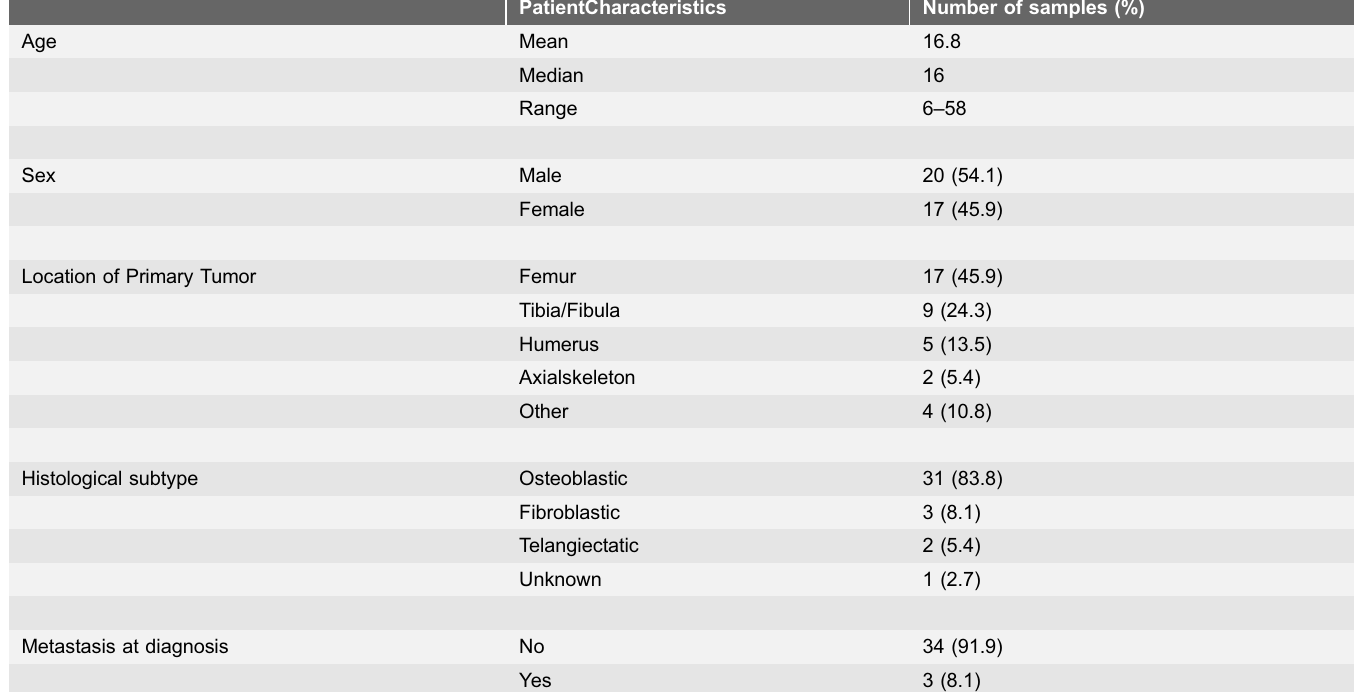
Table 1. Clinicopathological characteristics of patients and